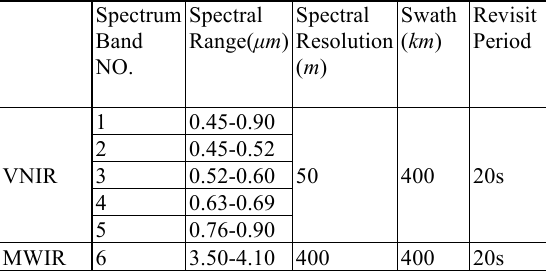
Table 1. The parameters of GF-4